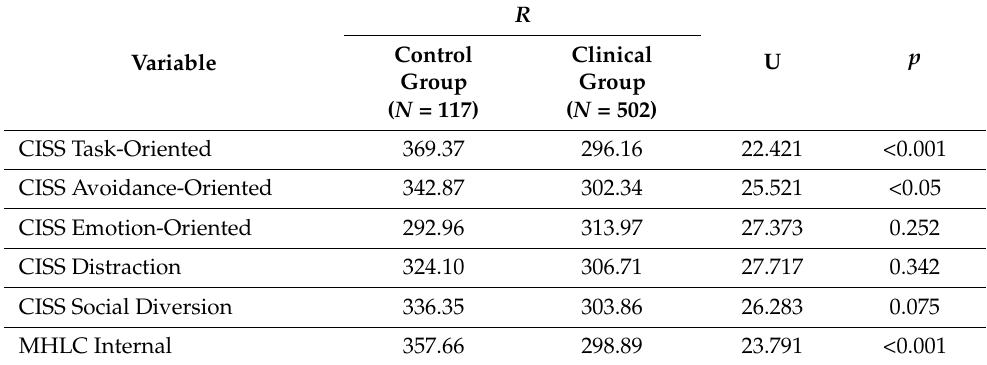
Table 3. Differences in psychological variables between the clinical group and the control